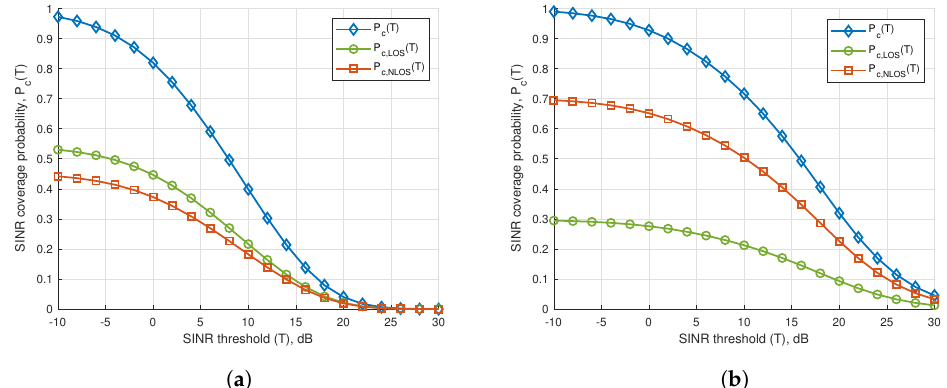
Figure 4. SINR coverage probability P c ( T ) vs SINR threshold (T) with LOS and NLOS path. ( a ) cell radius ( r c ) = 50 m ( b ) cell radius ( r c ) = 100 m.